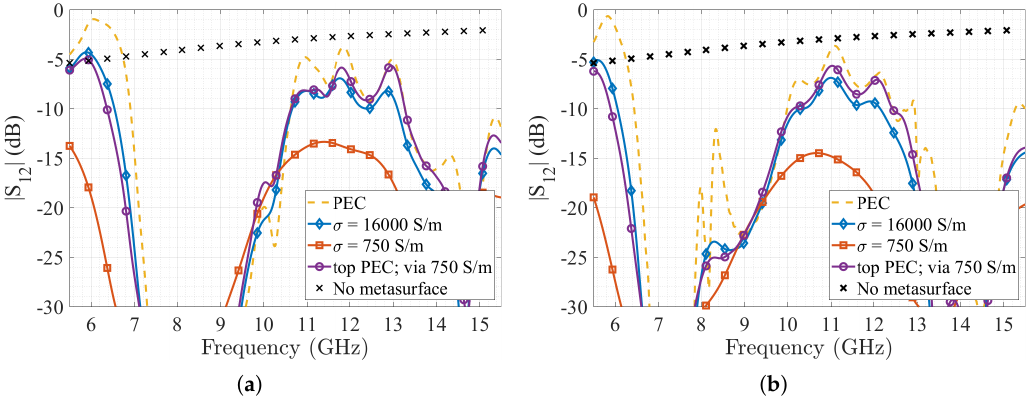
Figure 11. Suspended microstrip transmission coefficient | S 12 | as a function of the frequency, using different conductive materials for the metasurface; ( a ) 1 × 4 mushroom metasurface; ( b ) 3 × 4 mushrooms metasurface